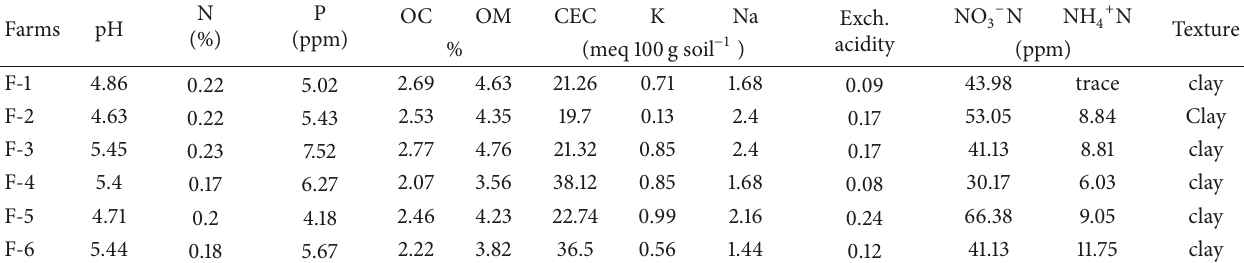
Table 1: Some physicochemical properties soil of farmer’s field before planting maize in Bako Tibe districts, western Ethiopia. Farms